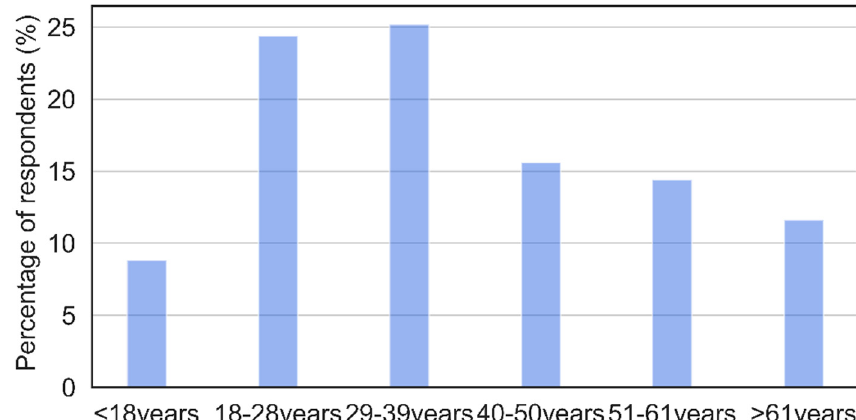
Figure 1. Age distribution of the respondents to the survey.